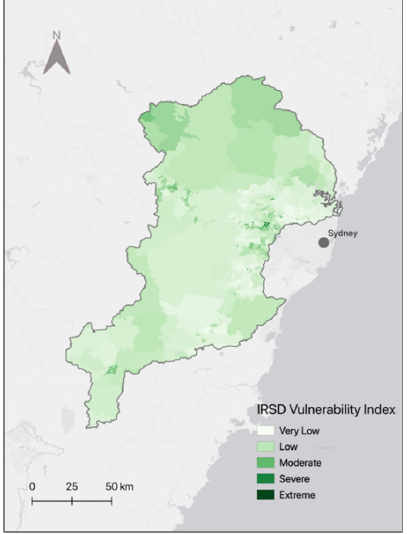
Figure 8. Map depicting Index of Relative Socio-economic Disadvantage (IRSD) data across the